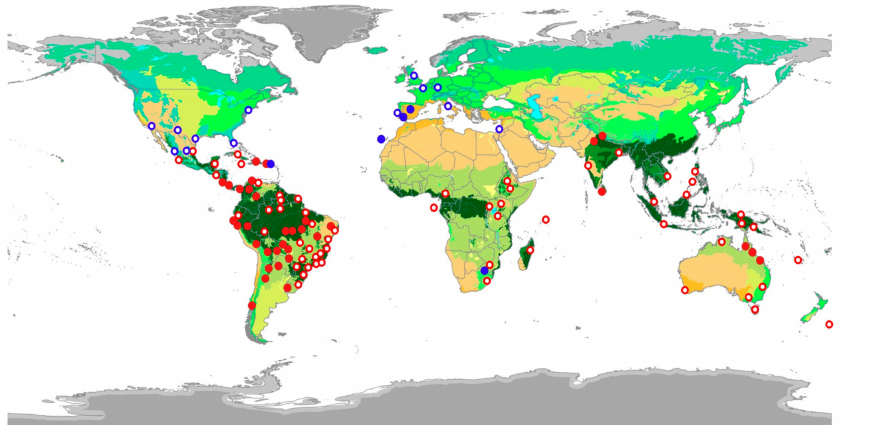
Figure 1. Locations of native (red circles) and non-native parrots (blue circles) recorded carrying attached seeds, with filled circles indicating our own observations and unfilled ones those recorded by wildlife photographers. Colors in the map represent the main terrestrial biomes of the world